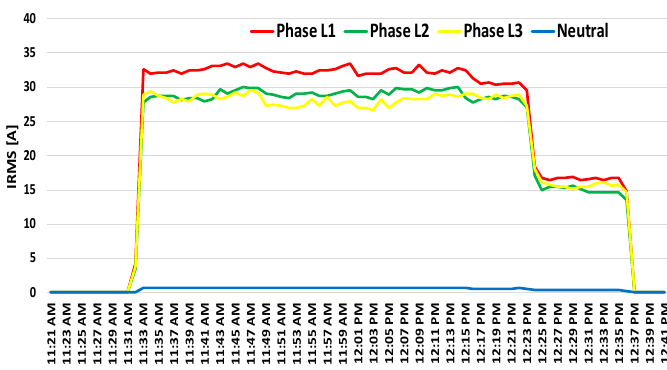
Figure 2. Evolution Root Mean Square (RMS) value of Current.